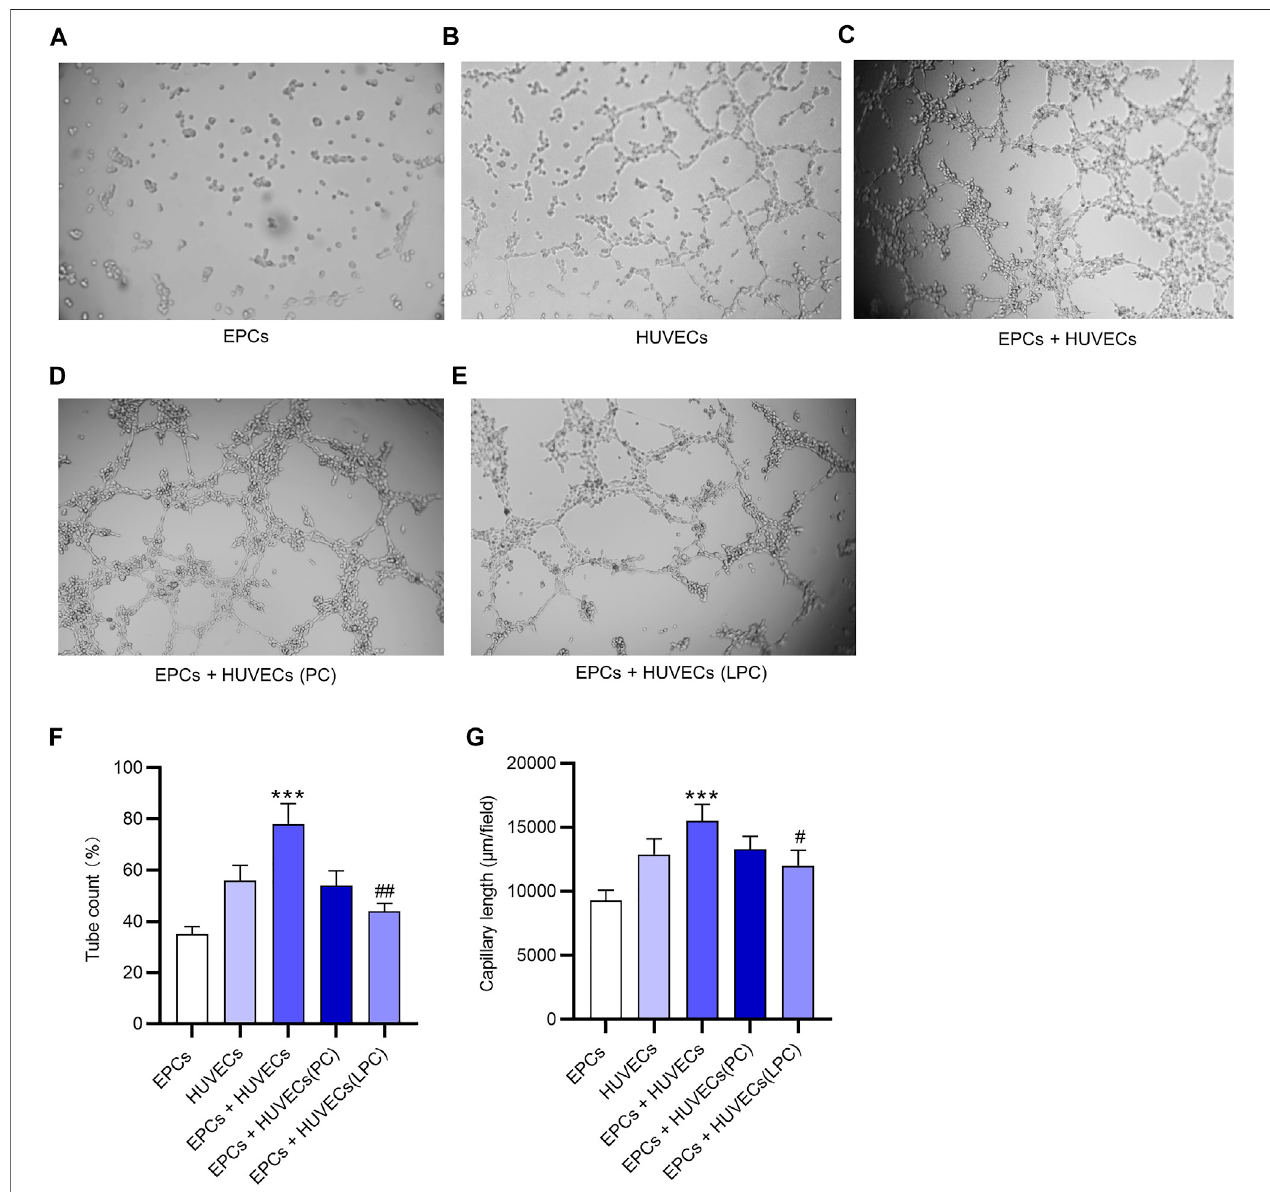
FIGURE 4 | The suppressive effect of LPC on the proangiogenesis of EPCs. (A) A tube formation assay was used to examine the angiogenesis potential of EPCs in vitro . (B) Tubes developed by HUVECs in vitro . (C) Tubes developed by HUVECs cultured with the supernatant of EPCs in vitro . (D) After the PCtreatment or (E) LPC treatment, the tubes formed by HUVECs that were cultured with supernatant of EPCs. (F,G) Tube count and capillary length of tubes in each group. *** p < 0.001 compared with the HUVECs group, # p < 0.05, ## p < 0.01 compared with the EPCs + HUVECs group.